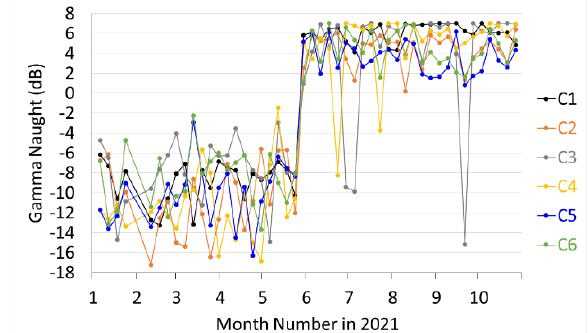
Figure 9. Series of gamma naught (i.e., radar brightness) reflected from 6 corner reflectors (C1 – C6) across open-pit mine owned by LEAG in Cottbus, Germany.